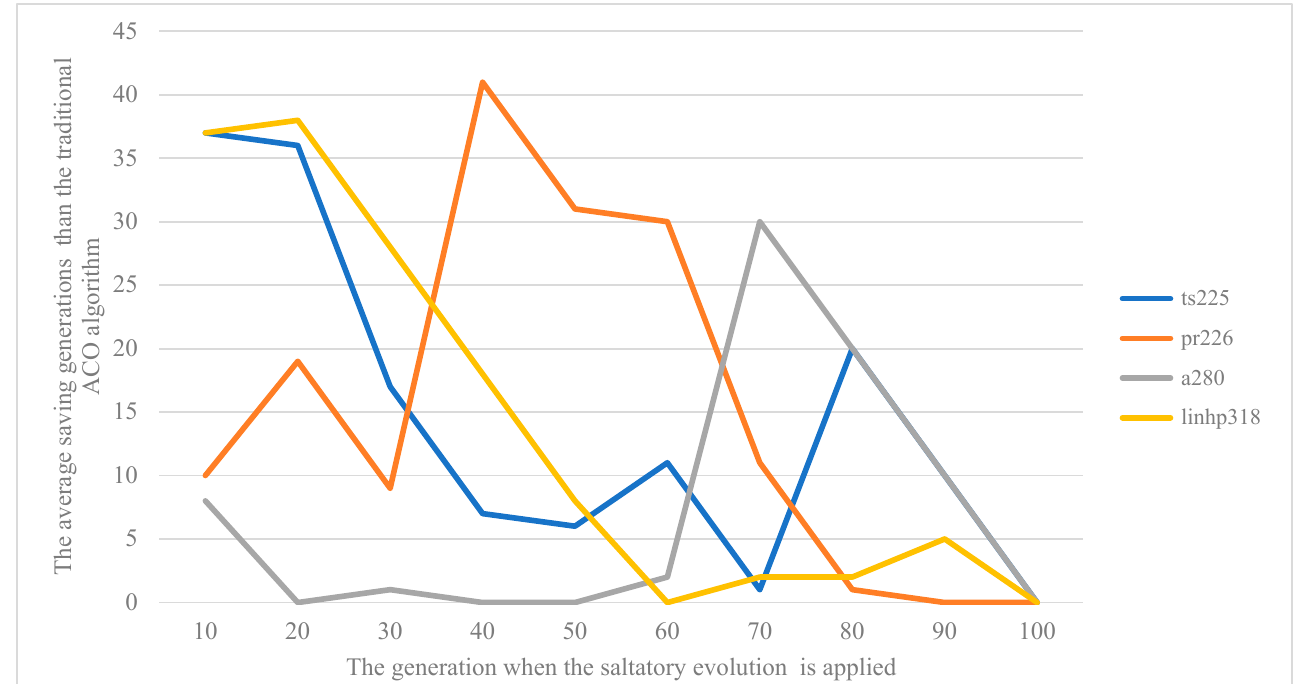
Figure 6. The optimization results of SEACO algorithm for data sets where n is in (100, 200].